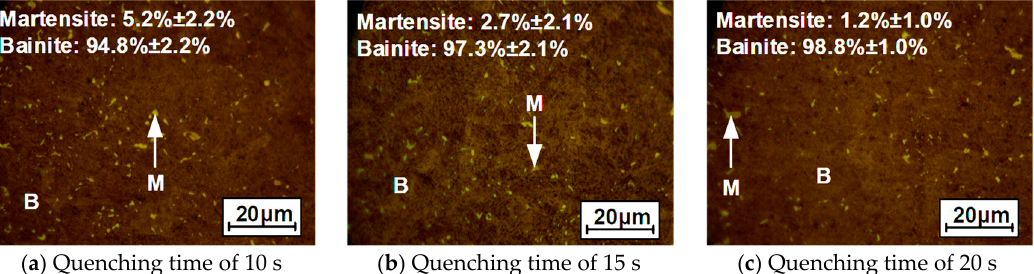
Figure 12. Microstructure for partially quenched part according to quenching time at heated tool temperature of 450 °C.